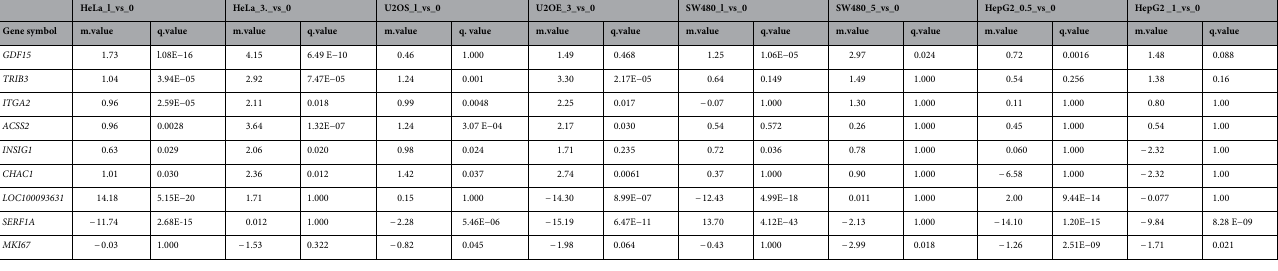
Table 1. Commonly modified genes in cancer cell lines with lidocaine treatment. Commonly modified genes in lidocaine-treated cancer cell lines from RNA-seq. m_value, log2 fold change (with and without treatment); q_value, false discovery rate